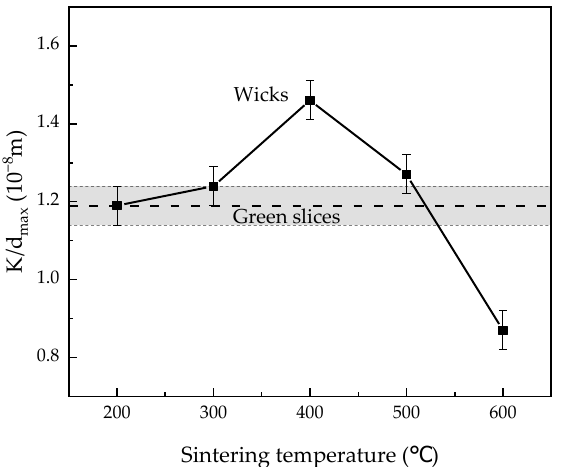
Figure 10. Capillary performance of green slices and wicks sintered at different temperatures.